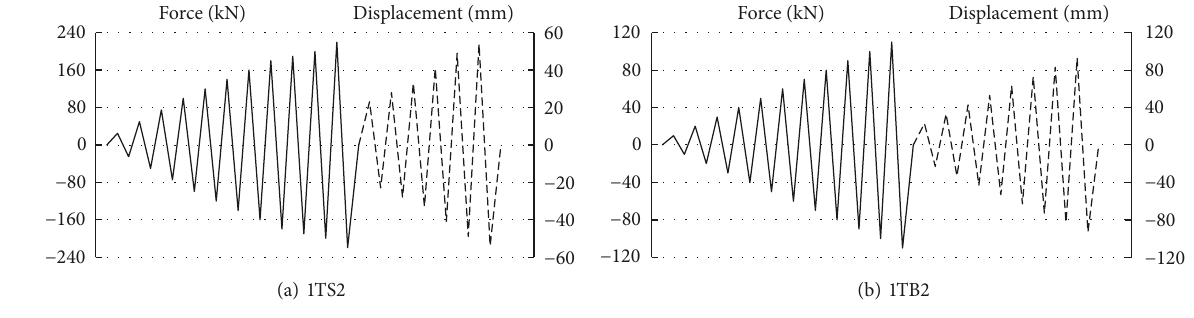
Figure 11: Loading history of test specimens.